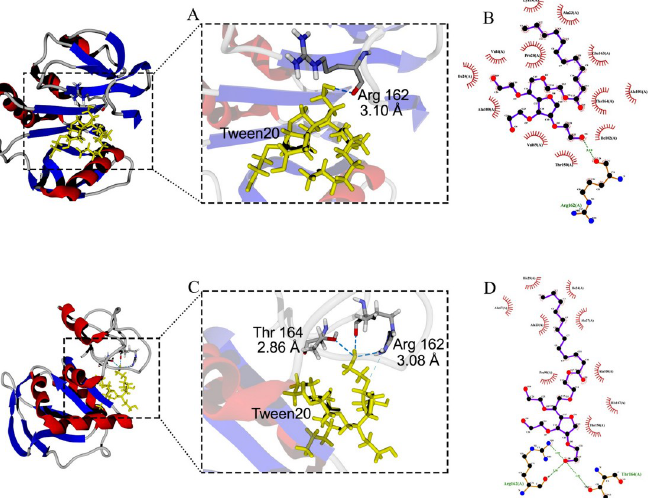
between oxygen atom at position 4 and Lys 19 in distance of 2.62 Å (Fig 6A and 6B). The pre- dicted hydrogen bond was lost at the end of 40 ns MD simulation, and SDS was stripped off from the protein (Fig 6C and 6D). The overall RMSD of the docked protease 1147-Tween 20 complex (0.23 nm) was in the lower value compared to the protease 1147 (0.39 nm) (Fig 7A). Root Mean Square Fluctuation (RMSF) plot indicated less structural fluctuation profile in the active site of protease 1147 in